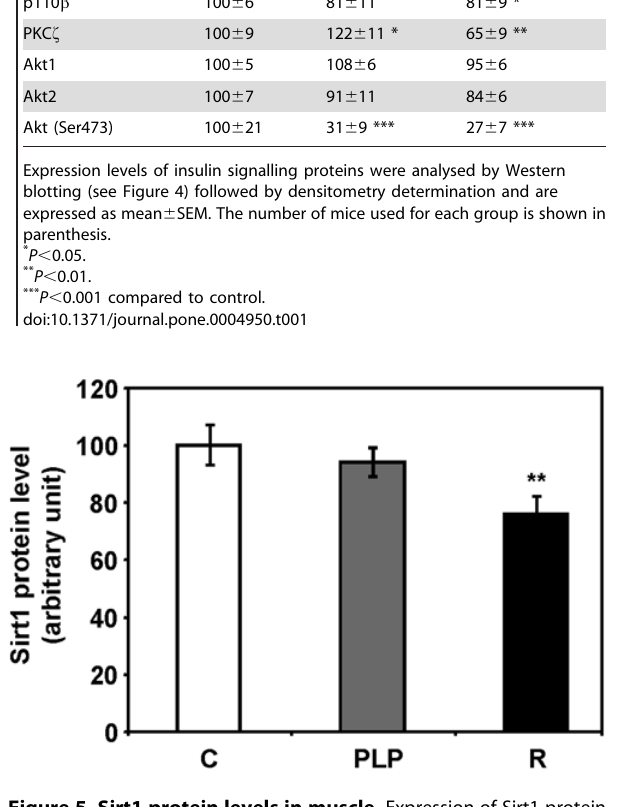
Figure 5. Sirt1 protein levels in muscle. Expression of Sirt1 protein was analysed by Western blotting. Protein levels were expressed as arbitrary units following densitometry analysis (** P , 0.01 compared to control; n=control (C): 8, postnatal low protein (PLP): 8, recuperated (R): 8).